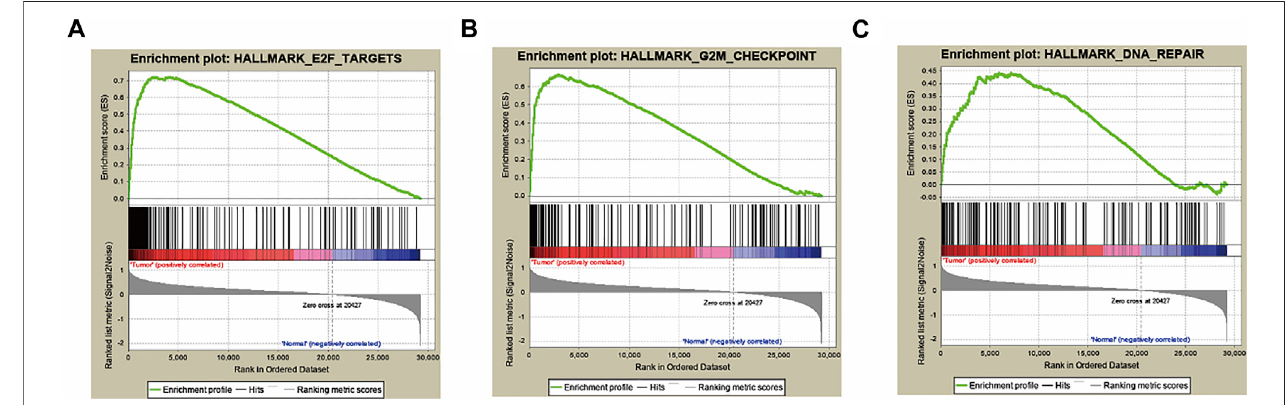
FIGURE 1 | Three hallmarks, including E2F targets, G2M checkpoint and DNA repair, were collected by GSEA analysis (A) E2F target gene set. (B) G2M checkpoint gene set. (C) DNA repair gene set.